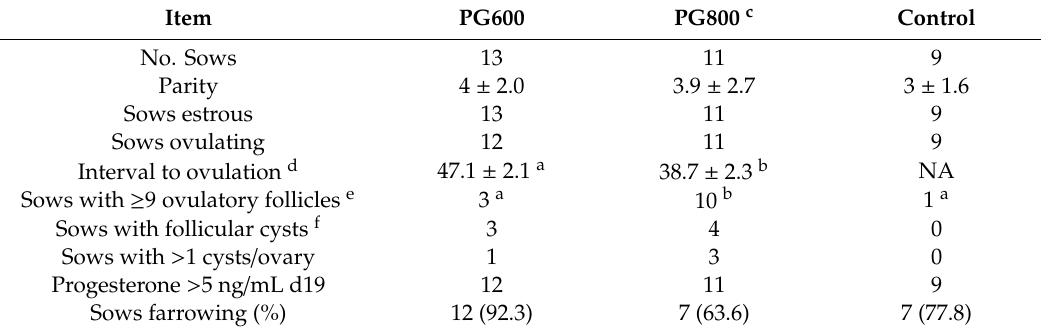
Table 1. E ff ect of human chorionic gonadotrophin (hCG) supplementation on estrus and ovulatory response, ovarian characteristics, farrowing rates, and subsequent litter size in PG600-treated weaned sows. Item PG600 PG800 c Control No.